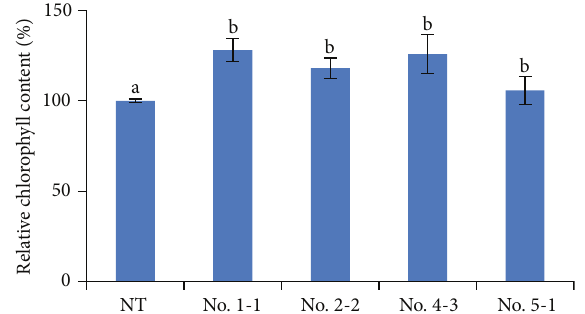
Figure 4: Relative chlorophyll content of transgenic M. sinensis plants with PHYB . The third leaf of the tillers was used for the extraction of chlorophyll (chl). Relative chlorophyll content was calculated by setting the chlorophyll content of nontransformed control plant (NT) to 100%. Error bars indicate standard errors ( 𝑛 = 5 ). Means with different letters are significantly different at 𝑃 < 0.05 , using